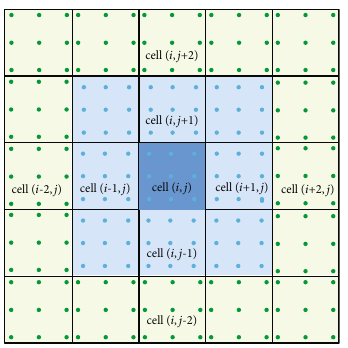
Figure 3: Three di ff erent types of cells. Troubled cells are marked in dark blue; bu ff er cells are in light blue; and smooth cells are in green.